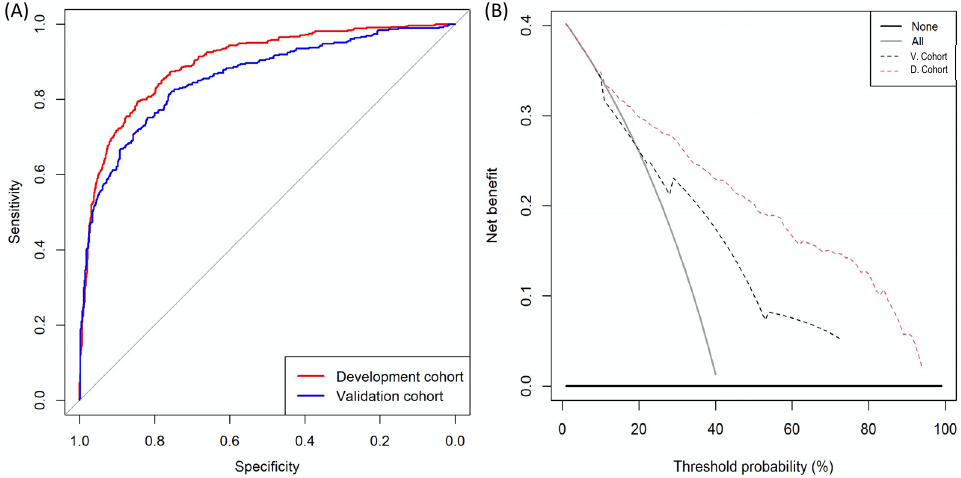
Figure 5. ( A ) ROC curves showing the efficacy of MRI-PM in development cohort and external validation cohort; ( B ) DCAs analysing the net benefit of MRI-PM in development (red interrupted line) and external validation (blue interrupted line) cohort over biopsying all men (continuous grey